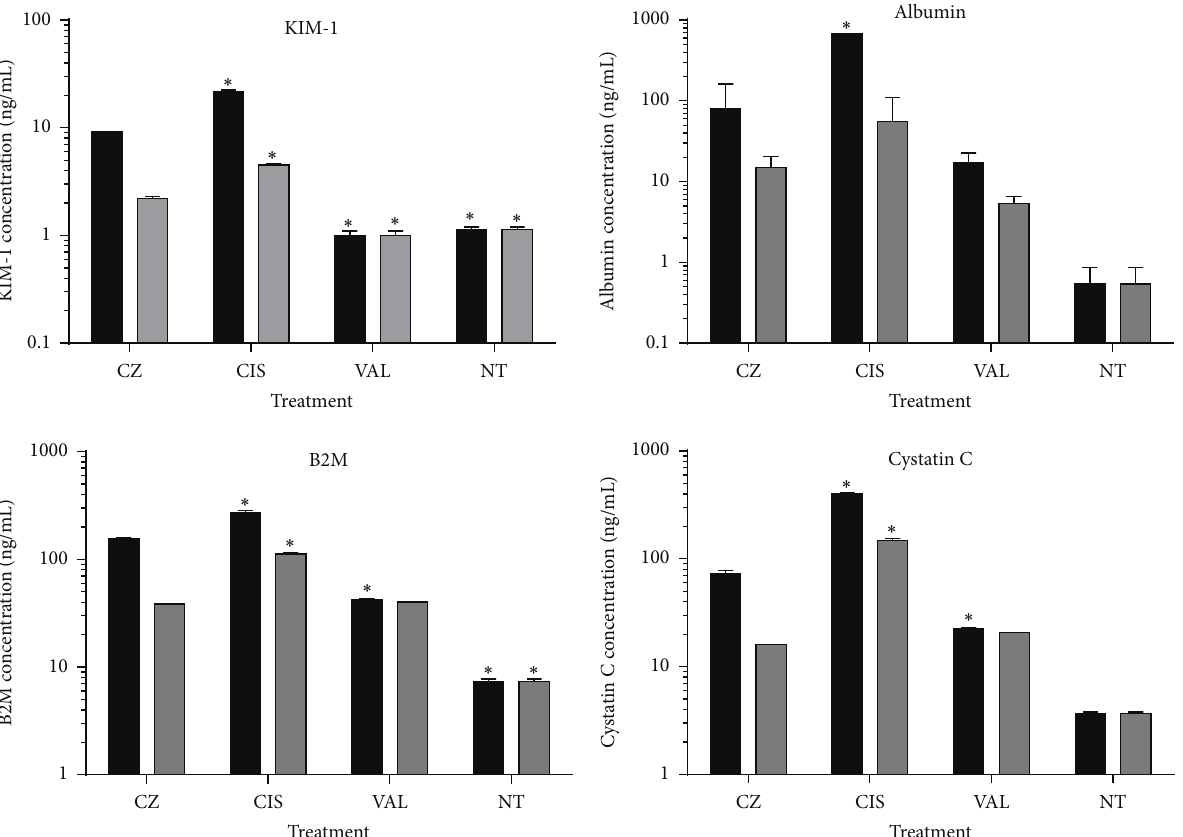
Figure 4: Biomarker signature of C. zacatechichi -associated nephrotoxicity. HK-2 cells were treated with C. zacatechichi (CZ), cisplatin (CIS), or valproic acid (VAL) or left untreated (NT). Treatment concentrations were either 333 𝜇 g/mL (black bars) or 111 𝜇 g/mL (gray bars). At 24 hours after treatment, HK-2 cell culture supernatants were harvested and assayed by Bio-Plex assay for average levels of KIM-1, Albumin, Cystatin C, and B2M ( ± SEM). Biomarker expression levels were normalized to cell viability. ∗ , cisplatin or valproic acid versus C. zacatechichi , 𝑃 < 0.01